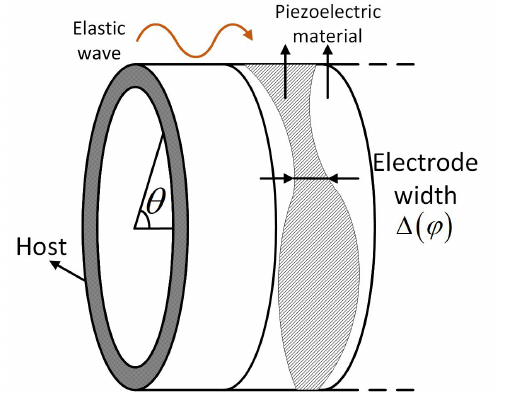
Figure 15. Transducer implemented on host structure. Piezoelectric material is extended along the circumferential direction. Hatched area is